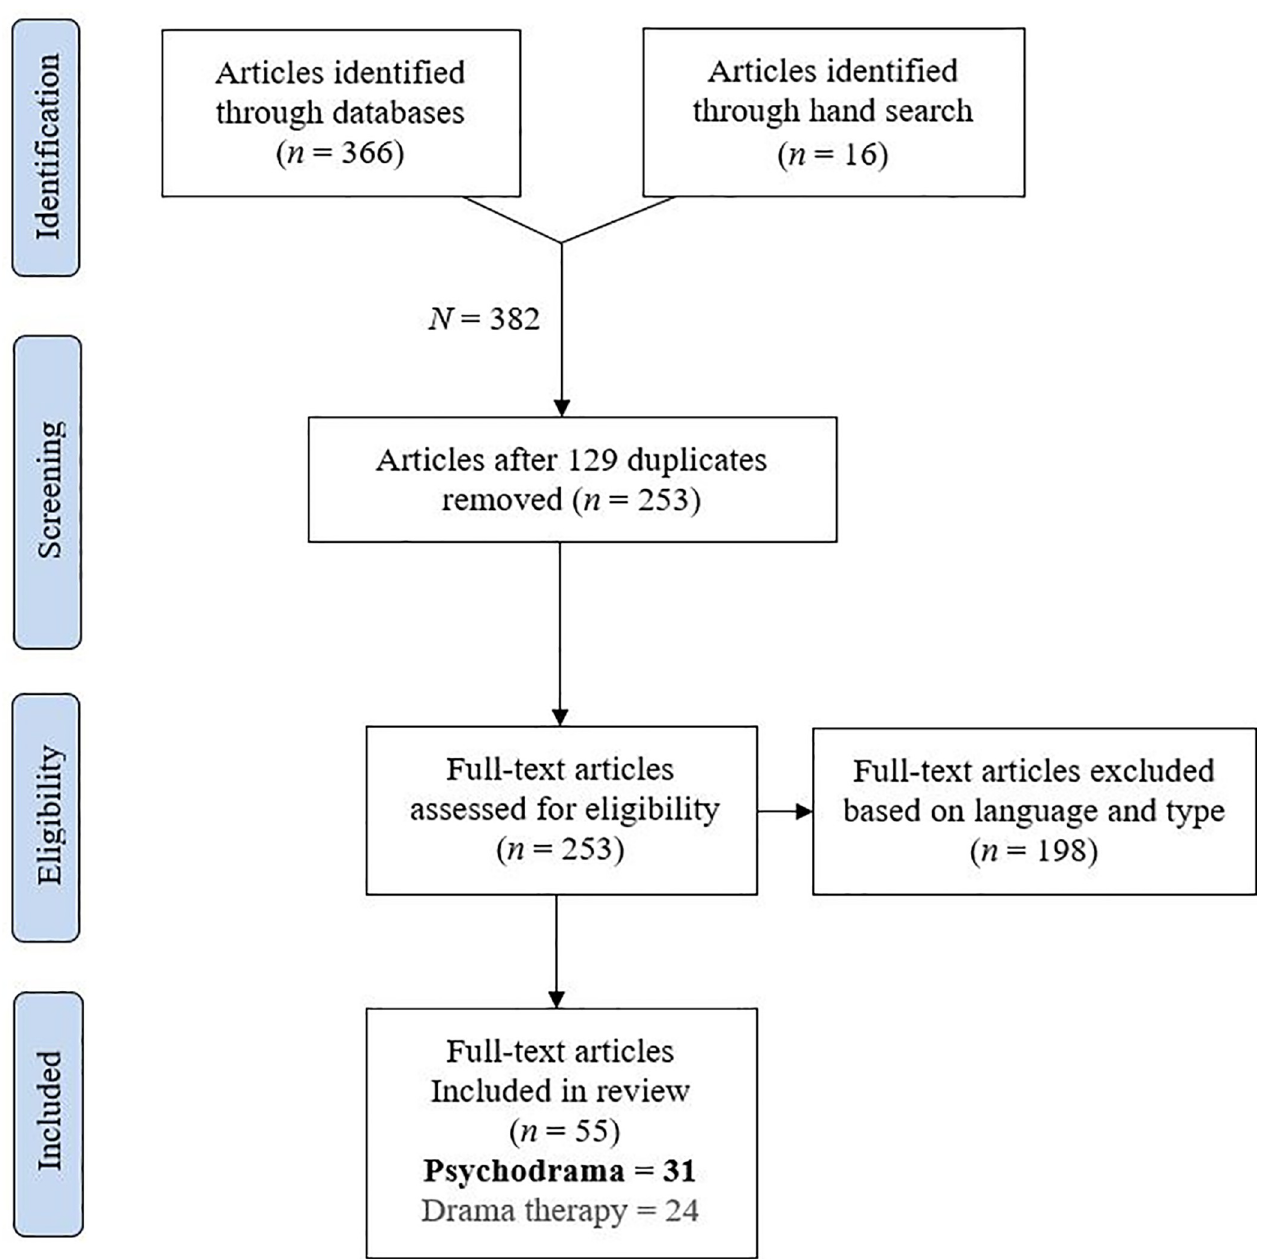
Fig 1. Systematic search according to the PRISMA statement